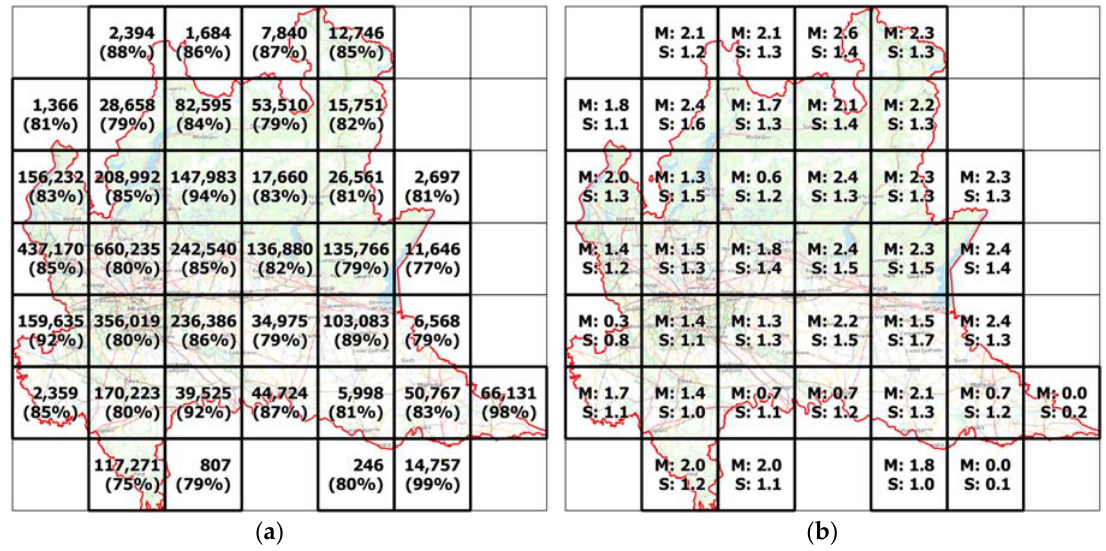
Figure 6. Homologous points detected using the general affine transformation in the search process. ( a ) Number and percentage of detected points with respect to the total number of OSM points; ( b ) Mean (M) and standard deviation (S) in meters of the distance of the homologous points.